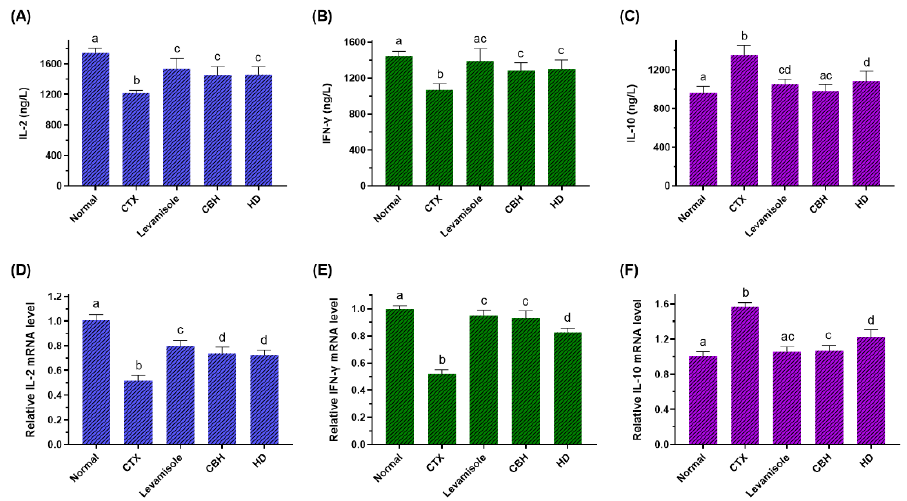
Figure 4. The effect of CHB and HD on the IL-2 ( A ), IFN- γ ( B ), and IL-10 ( C ) levels in the splenocytes, and the mRNA expression levels of IL-2 ( D ), IFN- γ ( E ), and IL-10 ( F ) in the spleens of CTX-treated mice. Data are presented as means ± SD ( n = 10). Different letters for the same index among the groups represent significant differences at p < 0.05.